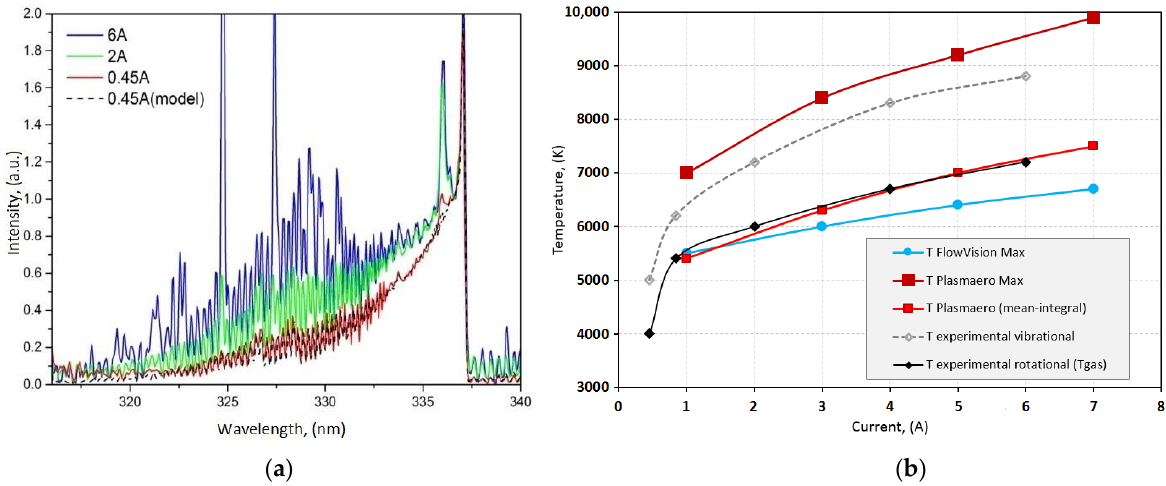
Figure 7. Typical spectra of discharges at the current variation ( a ) and comparison of the experi- ments and calculations by CFD temperature – current dependencies ( b ). and calculations by CFD temperature–current dependencies ( b